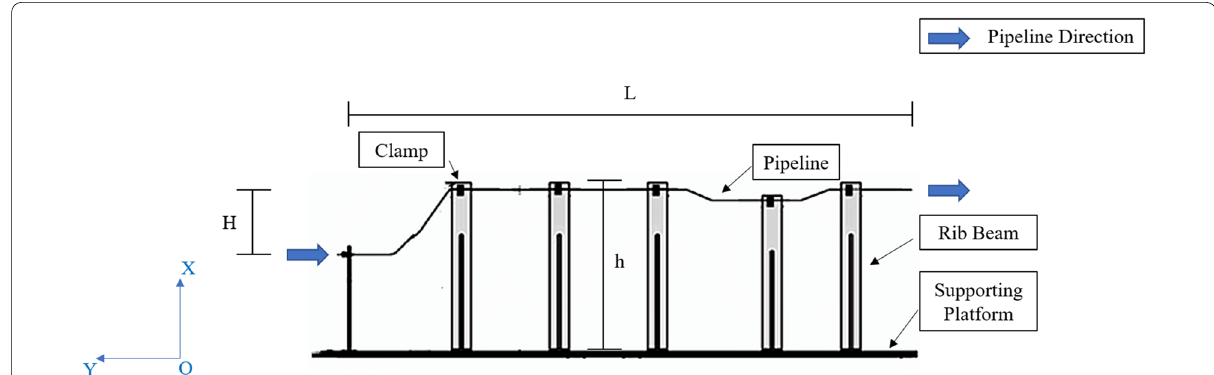
Figure 1 Multi-support pipeline system